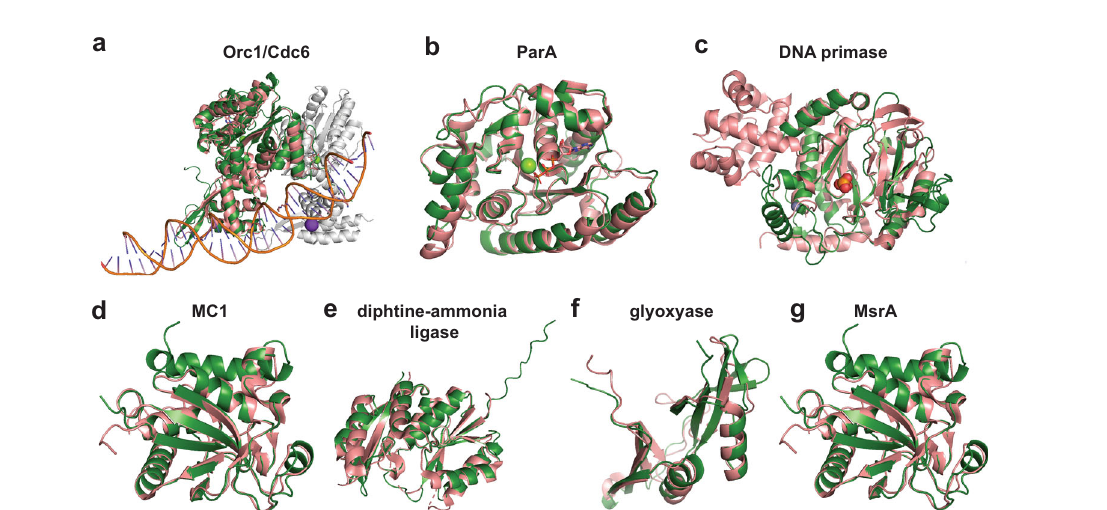
Fig.4 |PredictedstructuresofplasmidproteinsfromHMp_v1. Plasmid proteins (green)weresuperimposedonbesthits(salmon)fromPDBeFoldinpyMOL. a Orc1/ Cdc6(ORF1)andheterodimericOrc1-1/Orc1-3complexfrom Sulfolobussolfataricus (PDB:2QBY_A,RMSD=1.91).Orc1-3(2QBY_B)isdrawningray. b ParA(ORF167)and HpSoj from Helicobacter pylori (6iuc_A, RMSD=0.9). c DNA primase (ORF120) and P. furiosus homolog (PDB: 1v33_A, RMSD=1.91). d Nucleoid protein MC1 (ORF157)